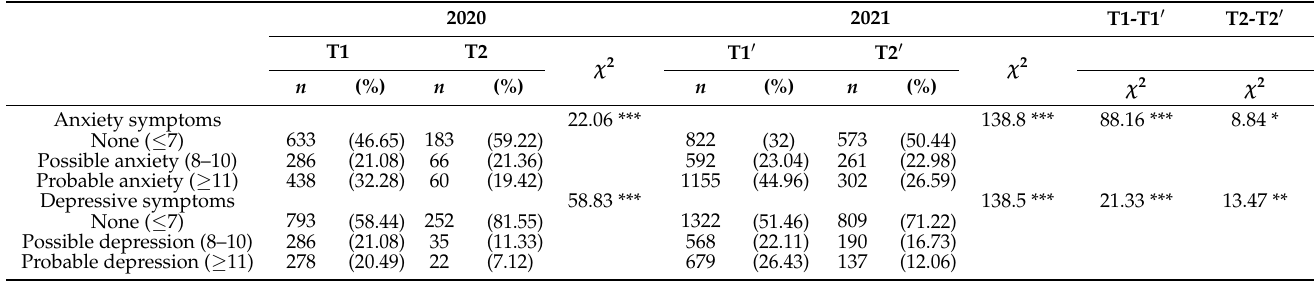
Table A2. Numbers and proportions of participants according to the different threshold HADS scores at the two respective time